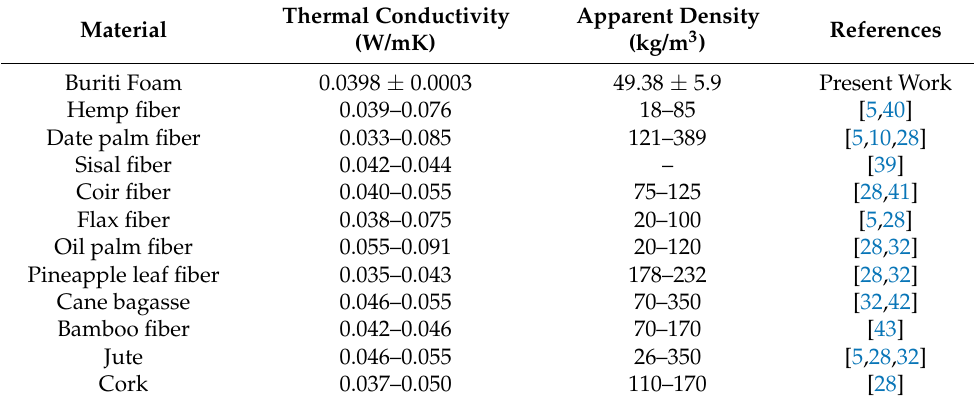
Table 6. Comparison of the thermal conductivity of the Buriti foam with other thermal insulating materials of plant